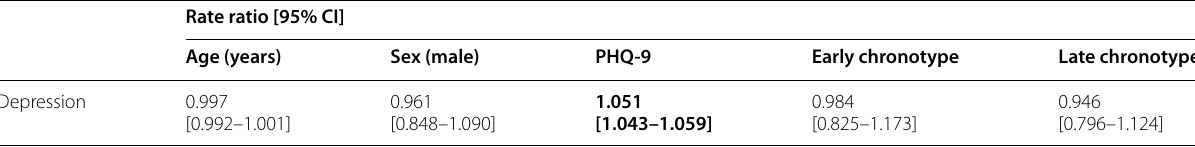
Females and normal chronotype were used as reference groups Bold RRs are significant at p < 0.01